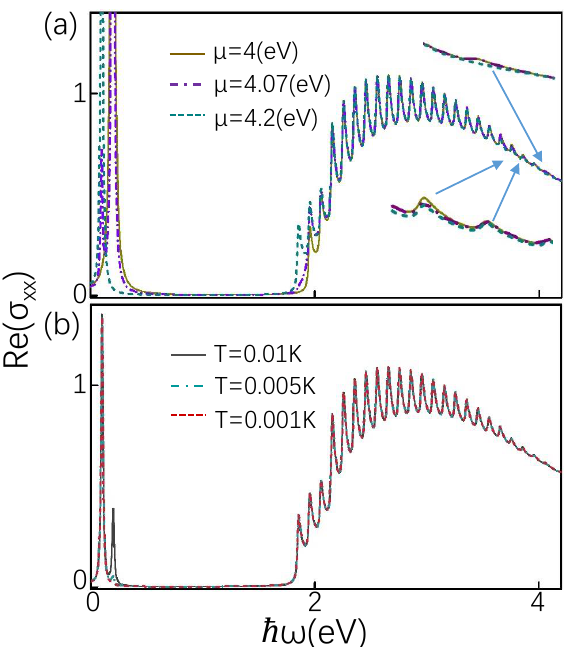
Figure 2. The real part of the longitudinal conductivity as a function of frequency (in units of e 2 ( a ) is plotted in several values of µ with B = 0.1 T and T = 0.01 K. ( b ) The effect of temperature on the optical conductivity is plotted in several values of T with B = 0.1 T and µ = 4.12 eV. The parameters N = 20, ∆ = 4 eV, γ = 0.5, Γ = 0.01 eV and e = 1.